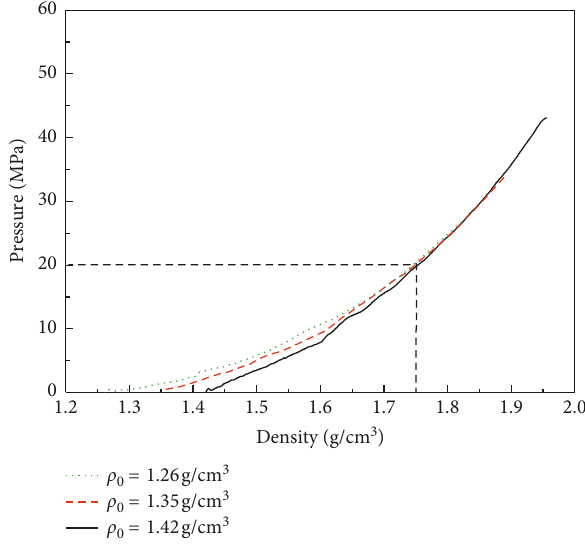
Figure 10: Relationship between lateral stress coefficient and axial stress.